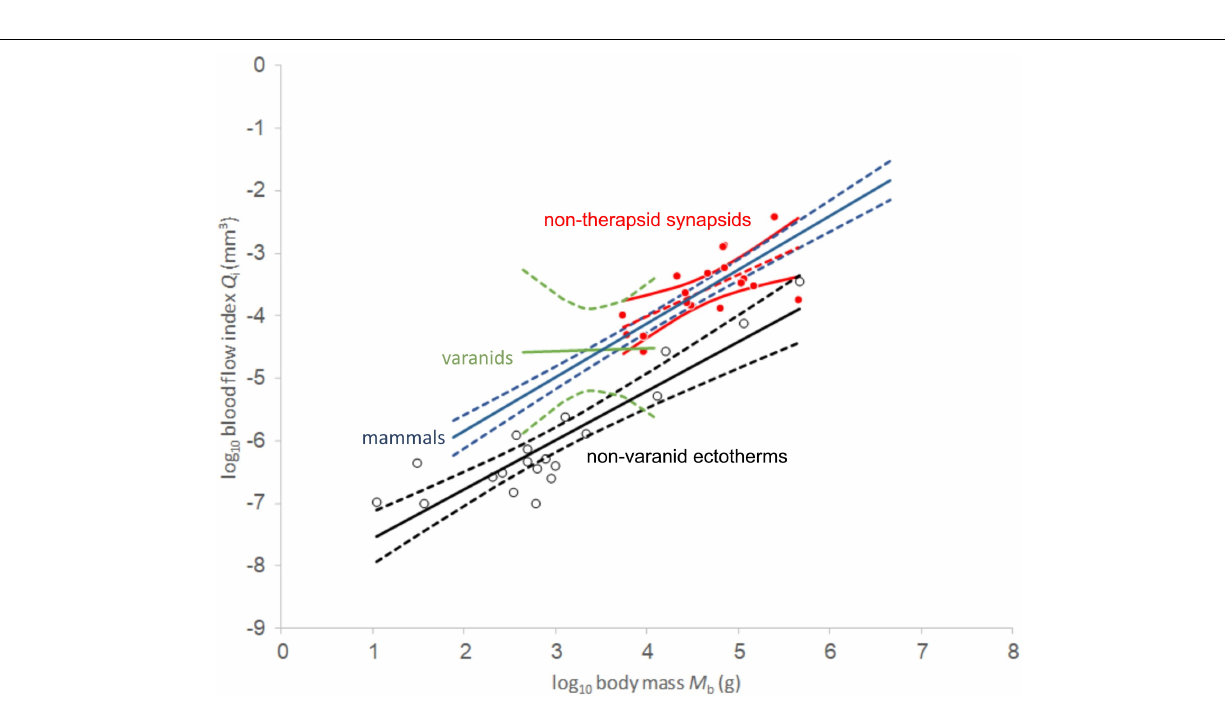
Frontiers in Ecology and Evolution |